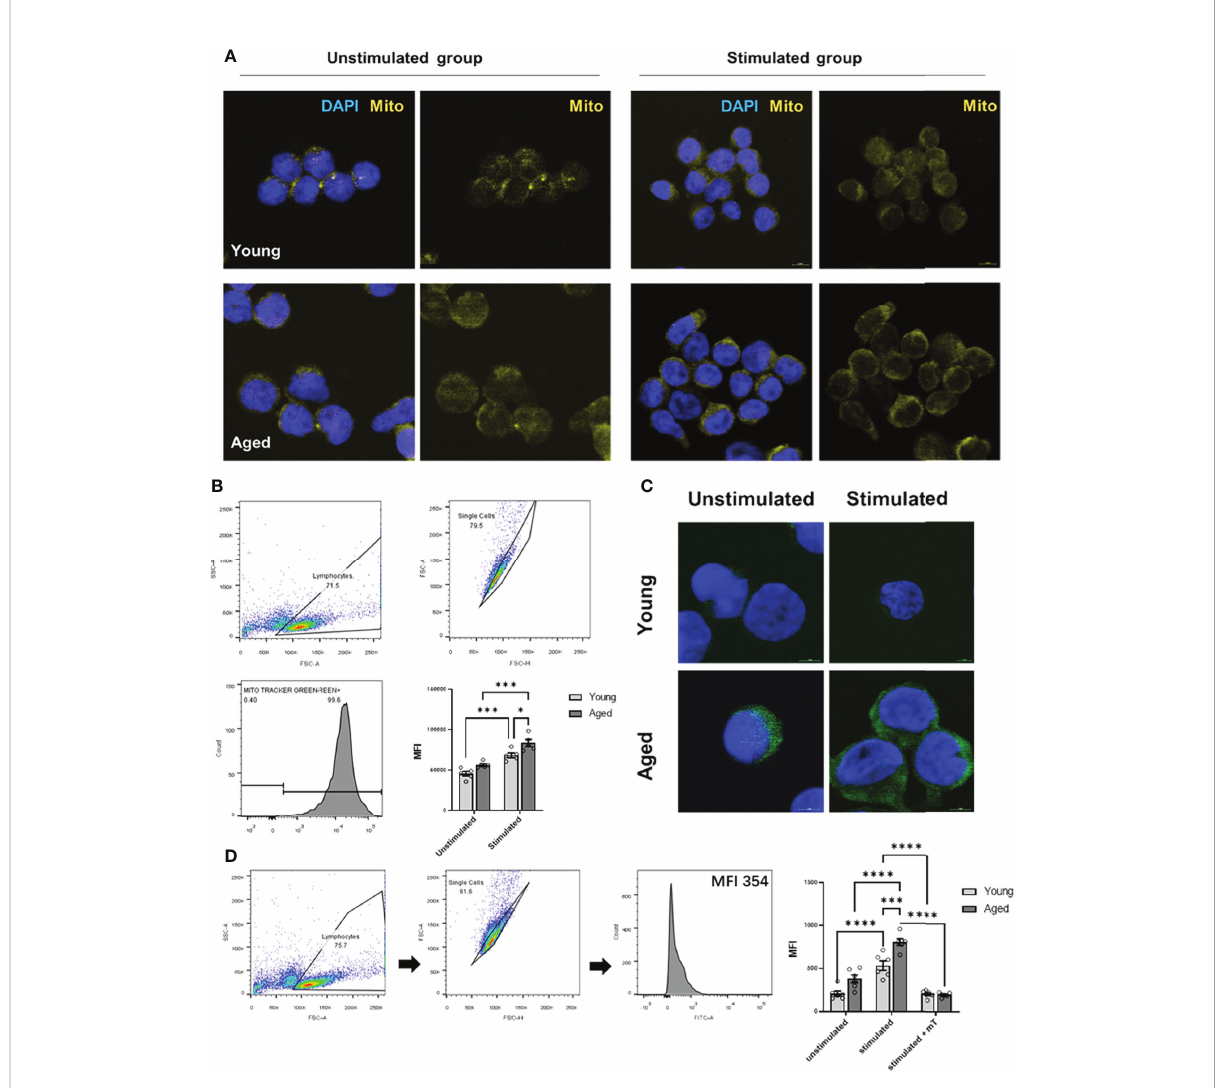
FIGURE 4 Mitochondrial content and intracellular ROS production of stimulated/unstimulated memory CD4 + T cells in young and aged male donors. (A) Representative images of mitochondrial content (yellow) in stimulated/unstimulated memory CD4 + T cells in young and aged male donors after 24 h visualized by immuno fl uorescence microscopy. Cells were stained using Mitotracker ™ (yellow) and DAPI (blue). The scale bar represents 10 m m. (B) Representative example of single-cell mitochondrial content Mitotracker ™ staining using fl ow cytometry (including gating) in stimulated and unstimulated memory CD4 + T cells and comparison of single-cell mitochondrial content via MFI in stimulated/unstimulated memory CD4 + T cells from young and aged donors (mean ± SEM; n = 6). (C) Representative images of intracellular ROS production (green) in stimulated/unstimulated memory CD4 + T cells in young and aged male donors after 24 h visualized by immuno fl uorescence microscopy. Cells were stained using DCF (green) and DAPI (blue). The scale bar represents 10 m m. (D) Representative example of single-cell intracellular ROS staining using fl ow cytometry (including gating) in stimulated and unstimulated memory CD4 + T cells and comparison of single-cell intracellular ROS via MFI in memory CD4 + T cells from young and aged donors were stimulated, stimulated and treated with mitoTEMPO (mT), and left unstimulated/untreated (mean ± SEM; n = 6). Multiple comparisons were analyzed by two-way ANOVA with the Bonferroni multiple- comparison post hoc test. *P<0.05, ***P<0.001, ****P<0.0001 (C, D)